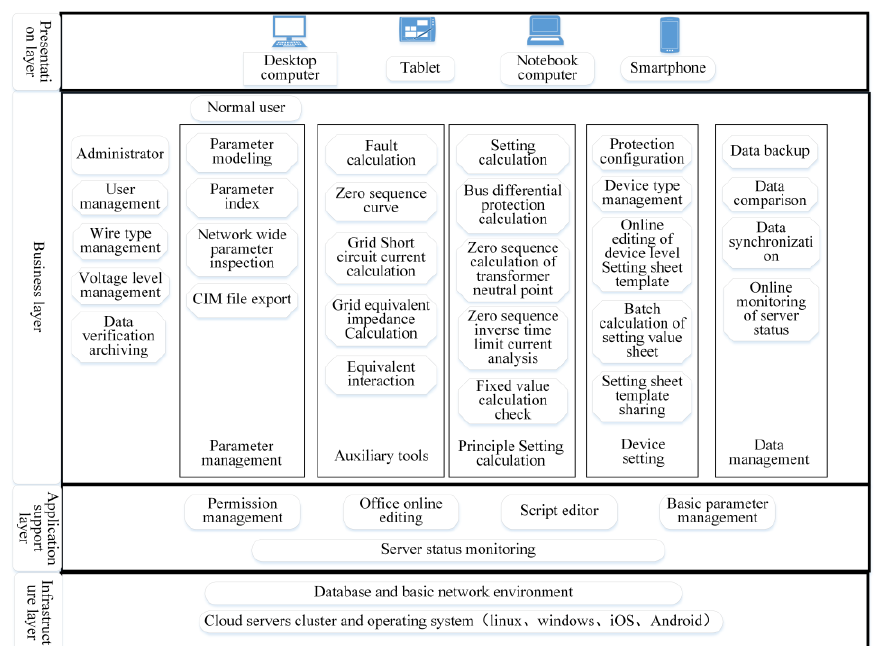
Figure 5. Setting calculation functional architecture.